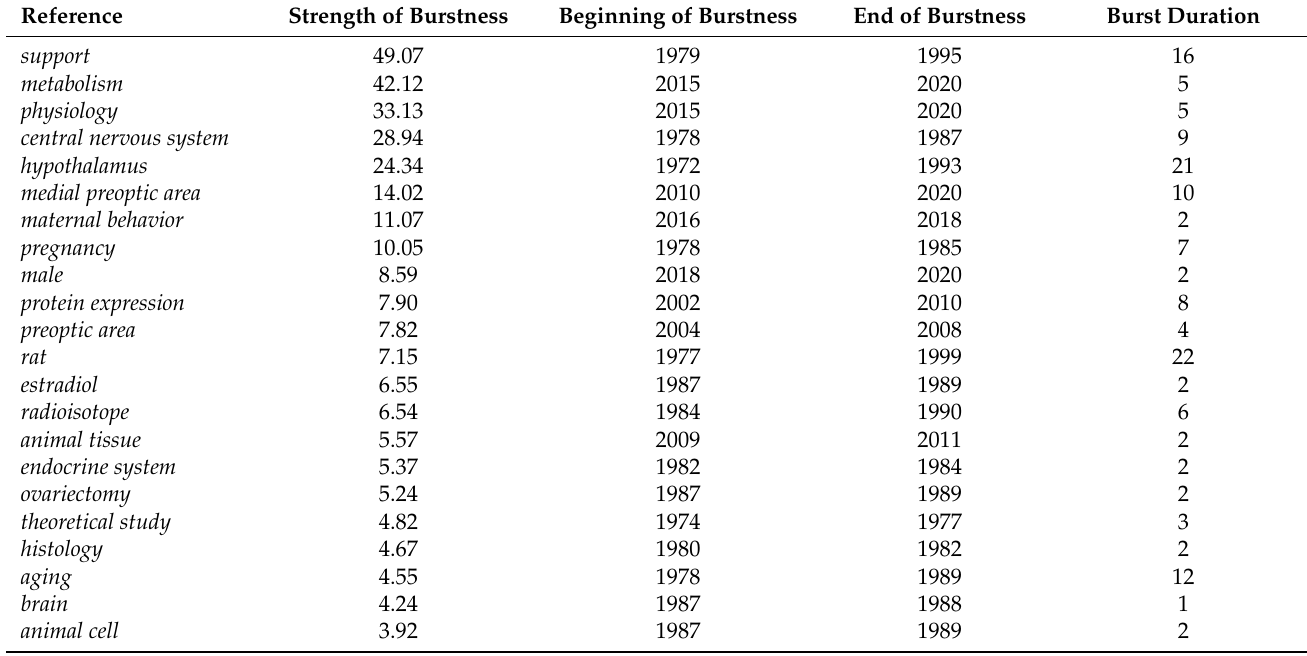
Table 3. Main characteristics of the twenty-two keywords with the generated citation burstness metrics in